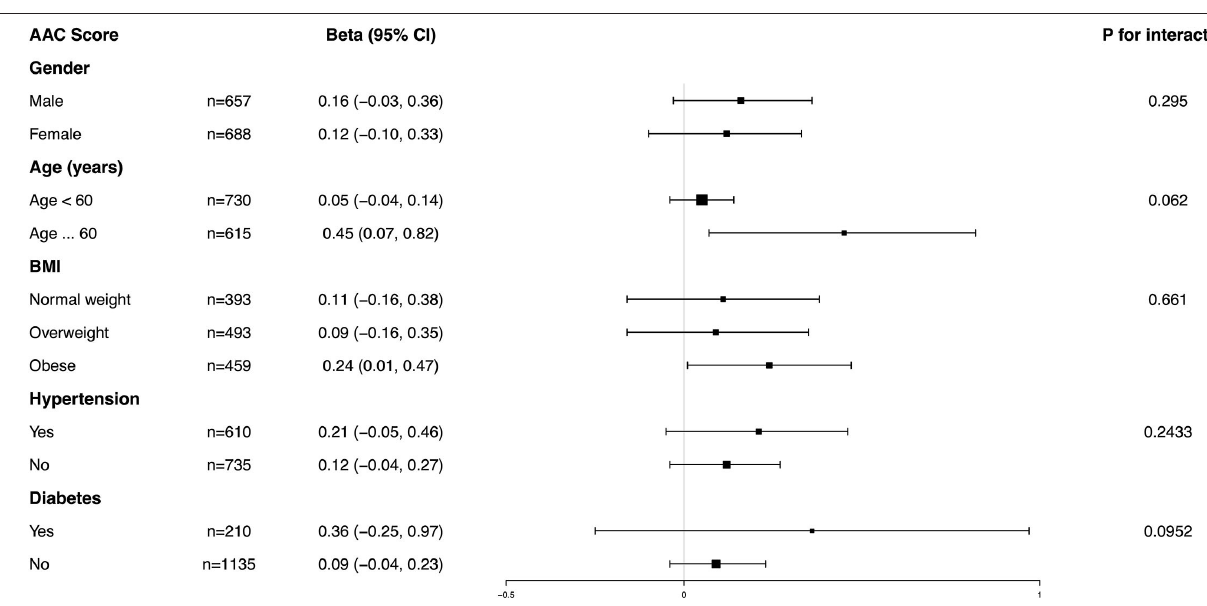
FIGURE 4 | Subgroup analysis for the association between blood cadmium concentration (BCC) and AAC